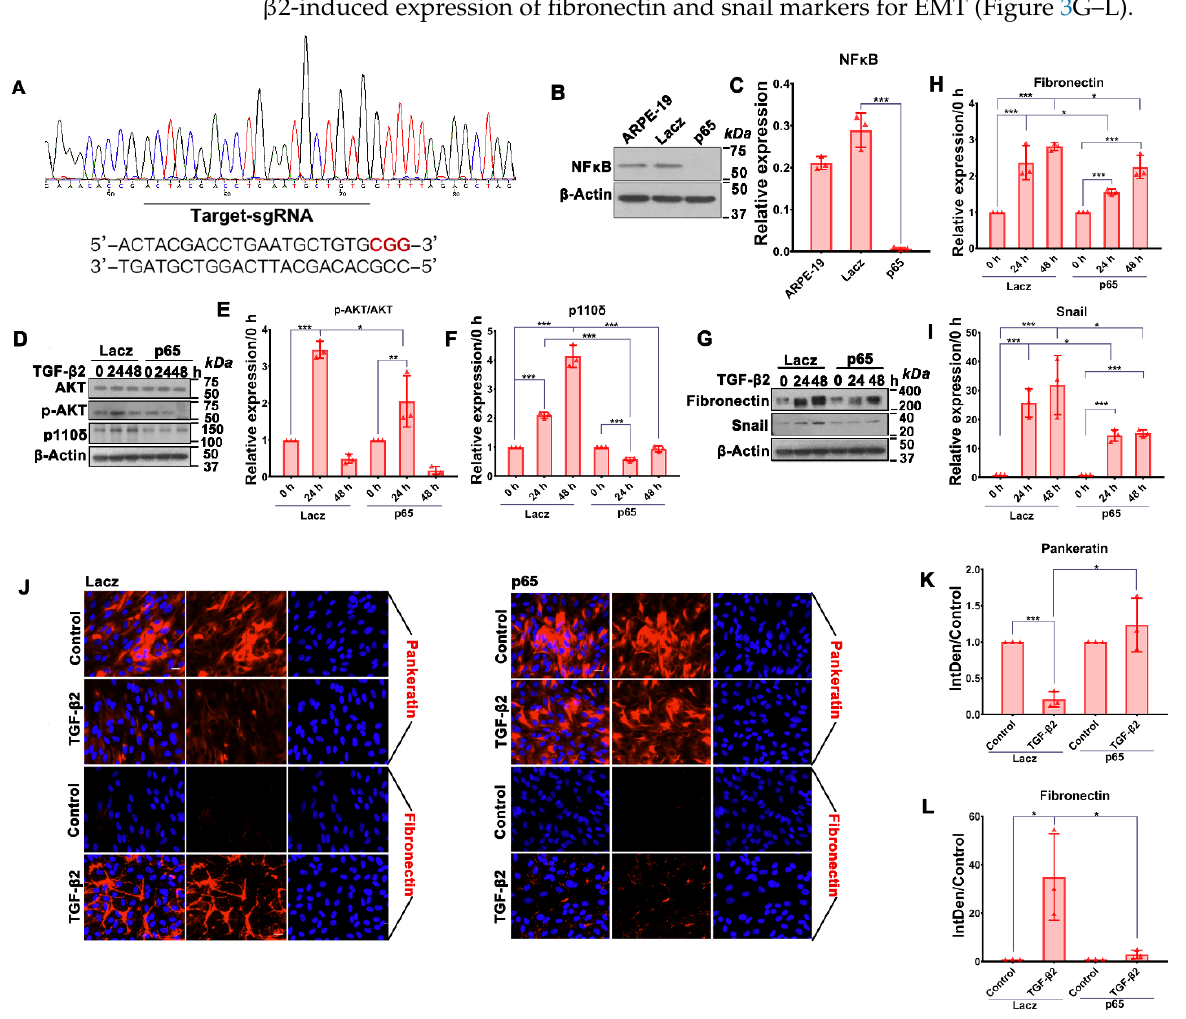
Figure 3. Depletion of NF κ B/p65 attenuates TGF- β 2-induced Akt activation, expression of p110 δ as well as EMT. ( A ). Sanger DNA sequencing identification of CRISPR-Cas9-mediated genome editing. ( B ). Western blotting analysis identification of CRISPR-Cas9-mediated protein depletion using the indicated antibodies. Shown is a representative of at least 3 independent experiments. ( C ). Quantitation of Western blotting band intensity. The graphs are mean ± SD of three independent experiments. The data were analyzed using one-way ANOVA followed by the Tukey HSD post hoc test. ( D , G ). Serum-starved cells with LacZ or NF- κ B/p65 sgRNA were treated with TGF- β 2 (10 ng/mL) for 24 h or 48 h. Cell lysates were subjected to immunoblotting analysis using the indicated antibodies. Shown is a representative of at least 3 independent experiments. ( E , F , H , I ). Quantitation of Western blotting band intensity in ( D , G ). The bar graphs are mean ± SD of 3 independent experiments. The data were analyzed using one-way ANOVA followed by the Tukey HSD post hoc test. ( J ). ARPE-19 cells expressing SpCas9 with LacZ or RELA (encoding NF- κ B/p65) sgRNA treated with TGF- β 2 (10 ng/mL) for 48 h were stained with antibodies to fibronectin (rabbit) and pan-keratin (mouse), followed by incubation with fluorescently labeled secondary antibodies. The slides were mounted in mounting medium containing DAPI (blue). Red signals indicate protein